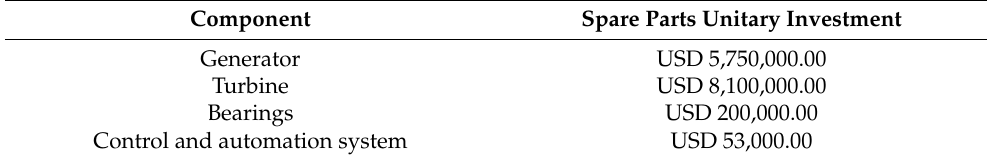
Table 3. Spare parts unitary investment for each